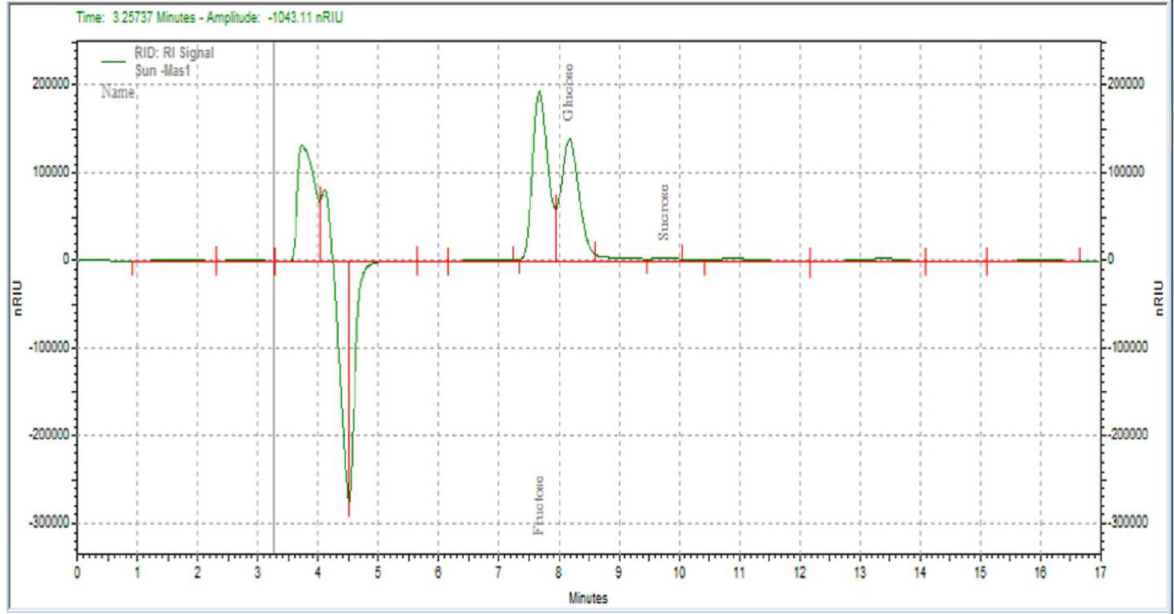
Fig 2. HPLC chromatogram for sugar profile of honey